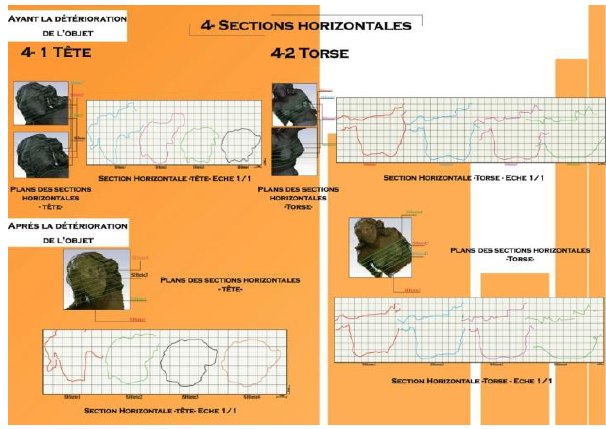
Figure 4. Example of sectional sections of the head of the statue Figure 2 . Process of merging pre and post incident situations.